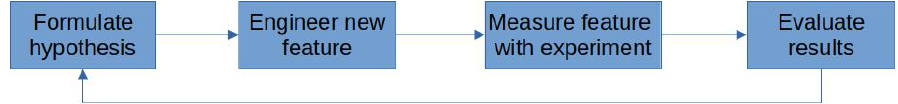
Figure 1. The process of feature engineering is analogous to the scientific